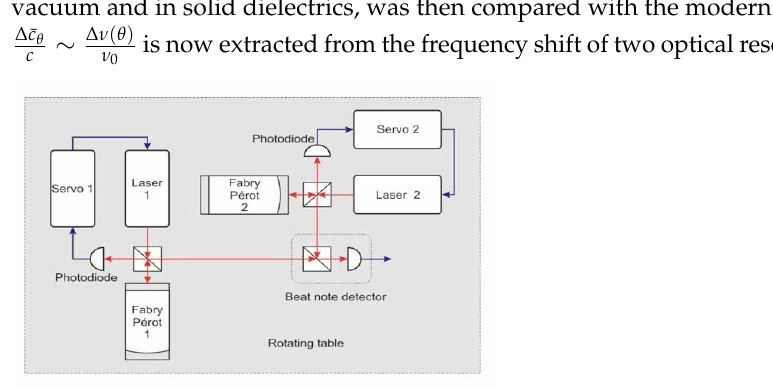
Figure 4. The scheme of a modern ether drift experiment. The light frequencies are first stabilized by coupling the lasers to Fabry–Perot optical resonators. The frequencies ν 1 and ν 2 of the resonators are then compared in the beat note detector, which provides the frequency shift ∆ ν ( θ ) = ν 1 ( π /2 + θ ) − ν 2 ( θ ) . For a review, see, e.g.,